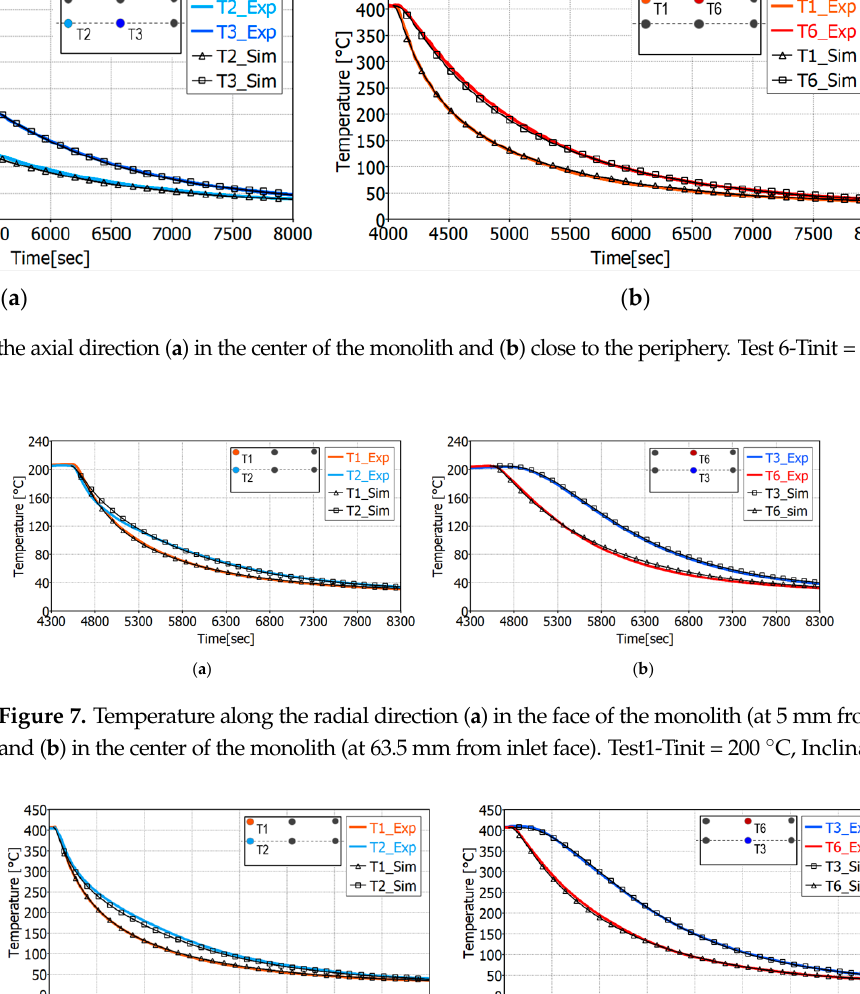
Figure 5. Temperature along the axial direction ( a ) in the center of the monolith and ( b ) close to the periphery. Test 1-Tinit = 200 °C, Inclination = 0°.